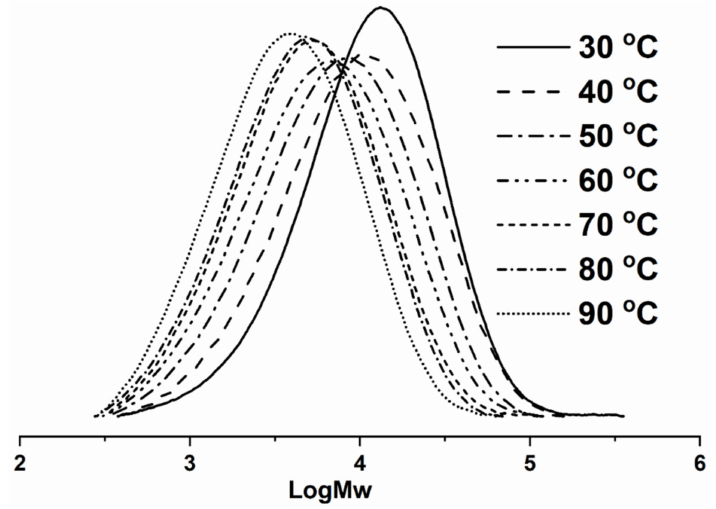
Figure 5. GPC curves showing log M w of the polyethylenes produced using Co1/ MAO as a function of the reaction temperature (runs 1–7, Table